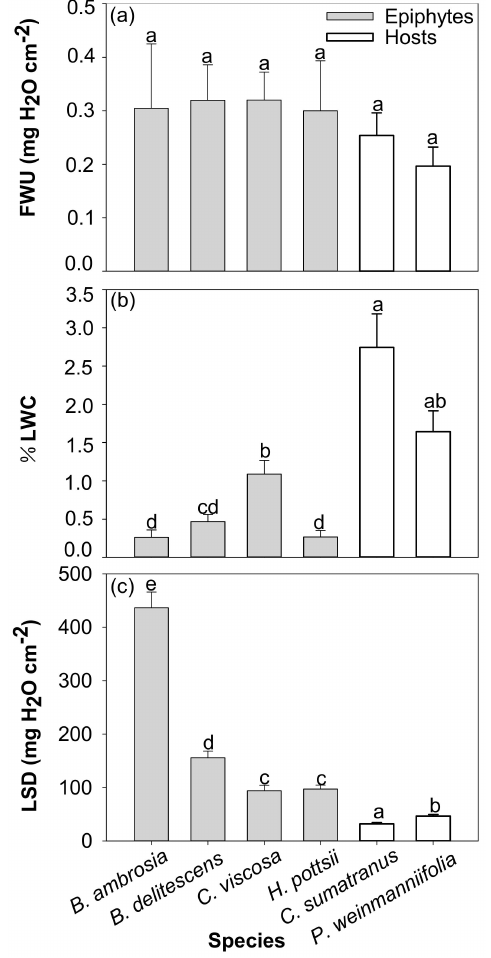
Figure 5. Foliar water uptake in epiphytes and their host trees. ( a ) Foliar water uptake capacity per unit area (cm 2 ) ( n = 10); ( b ) percent increase in leaf water content following immersion in water for 3 h (%LWC) ( n = 10); ( c ) leaf succulence degree (LSD) ( n = 10). Bars are means ± SE and letters represent significant differences at p <